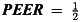
Comparison of the reconstructed profiles versus the ground truth when PEER = 12 without data noise.The blue solid lines are the reconstructed profiles; while the red solid ones are the ground truth. All the pixels are outside the spectral FOV/ROI defined by the PCDs. From (a) to (h) are the results in the 1st to 8th energy channels respectively. The two red ellipses in (a) show the Gadolinium clusters.